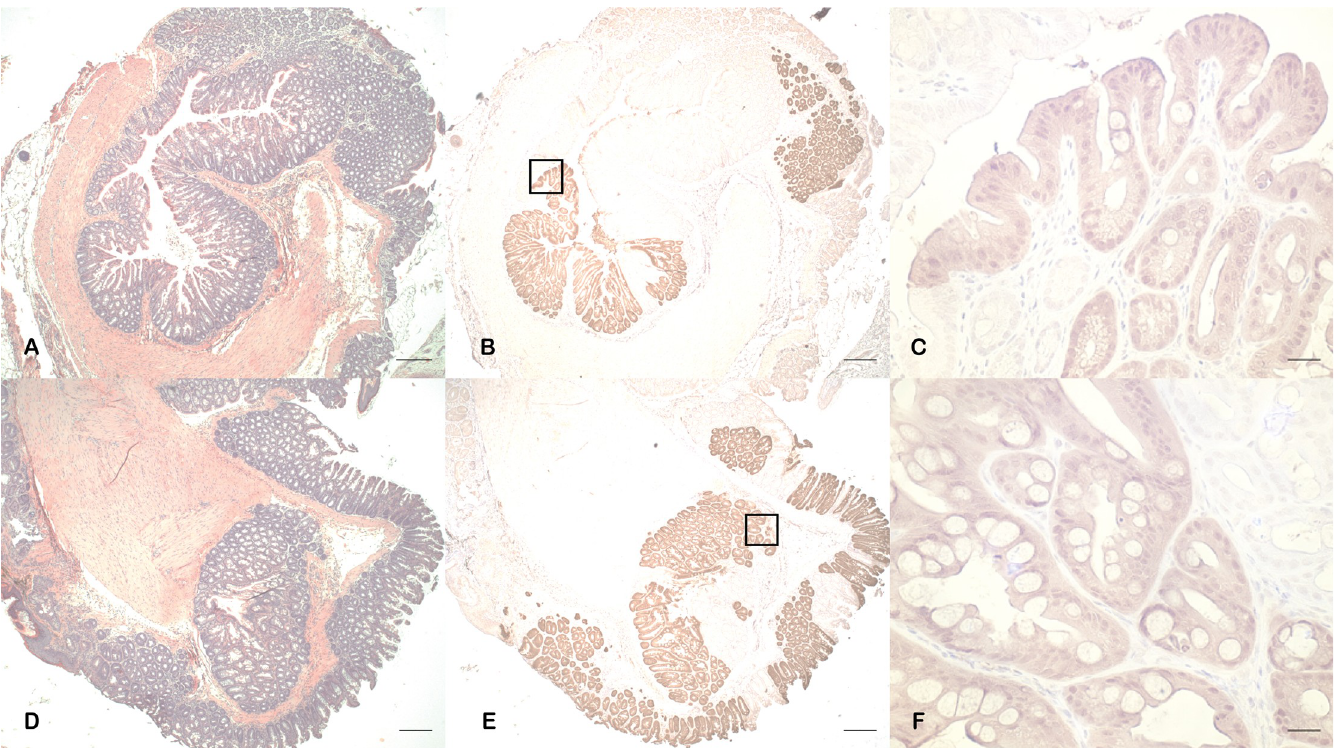
Fig 5. Tdtomato expression indicates Pdx1-Cre expression and mutant Kras expression in both male and female mice. Anal tissue was excised from 3 month old Ai14; LSL-Kras G12D ; Pdx1-Cre (AiKC) female (A, B, C) and male (D, E, F) mice, fixed and frozen embedded and sectioned for H&E analysis (A and D). Additional adjacent sections were prepared for immunohistochemistry (IHC) to identify tdTomato protein at 4x and 10x (B, C, E and F). Scale bars equal 100 μ m. Positive IHC signal for tdTomato reveals the location of Cre expression ( Pdx1-Cre ), which serves as a marker for the location of mutant Kras G12D expression.